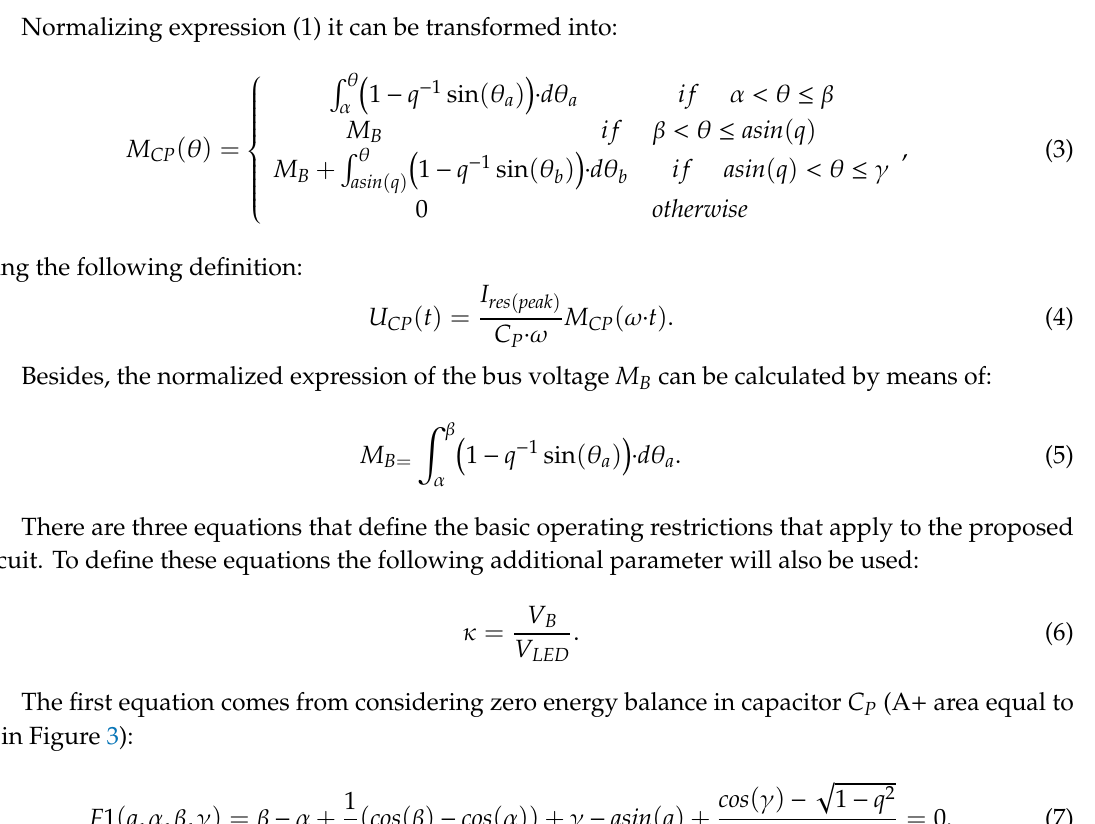
Figure 3. Detailed circuit waveforms and angle definitions.